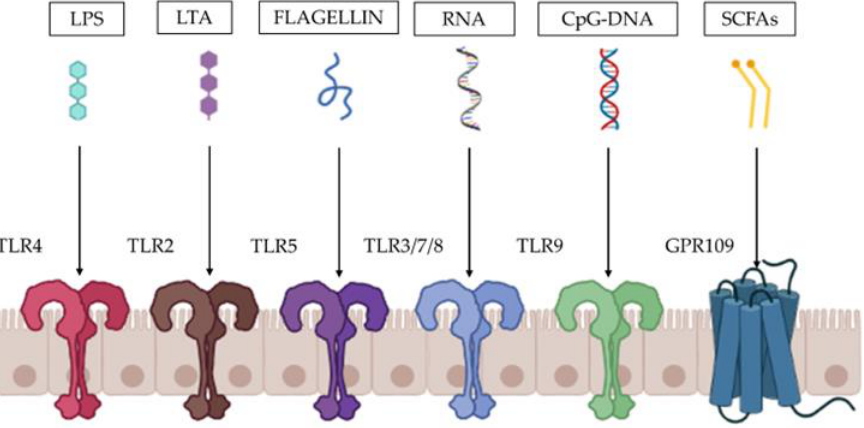
Figure 1. Main active components of the postbiotics . The positive effects elicited by the postbiotics on human health may result from the combined action of one or more components regulating different mechanisms. These effects could be related to the activities of the inanimate probiotics, bacterial components (i.e., lipoteichoic acid, peptidoglycans, bacteriocins, enzymes, nucleotides and/or peptides), and/or metabolites (such as short-chain fatty acids, SCFAs).